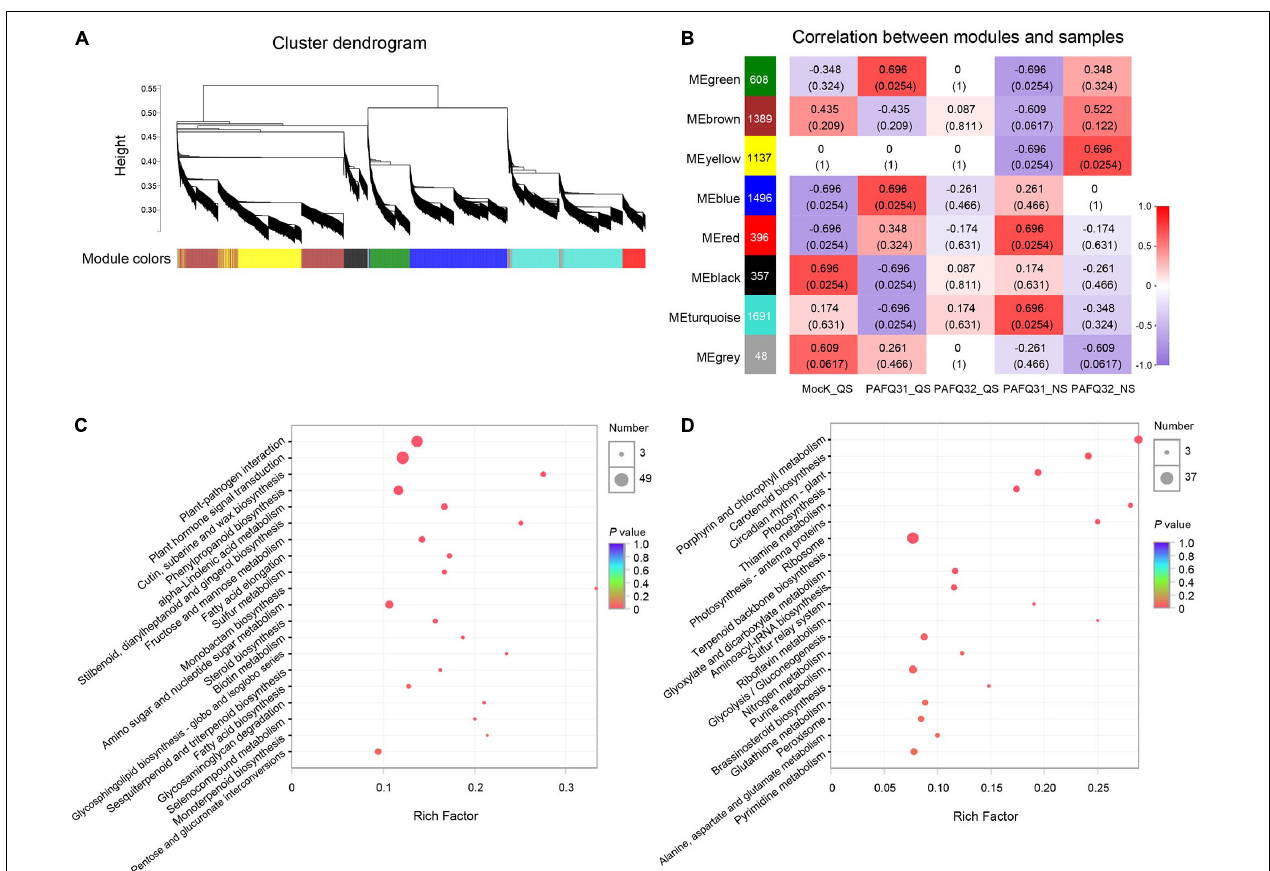
FIGURE 6 | WGCNA for the DEGs of P. pyrifolia at QS and NS in response to C. fructicola infection. (A) Gene co-expression modules were identified for the DEGs for the infection of both C. fructicola strains. Different colors represent different gene modules. (B) Association between modules and samples. The numbers in each cell are the correlation coefficient (top) and P -value (bottom). A colored bar indicating the level of correlations between modules and samples. (C) KEGG pathways based on the ‘MEyellow’ and ‘MEbrown’ modules. (D) KEGG pathways based on the ‘MEred’ and ‘MEturquoise’ modules.